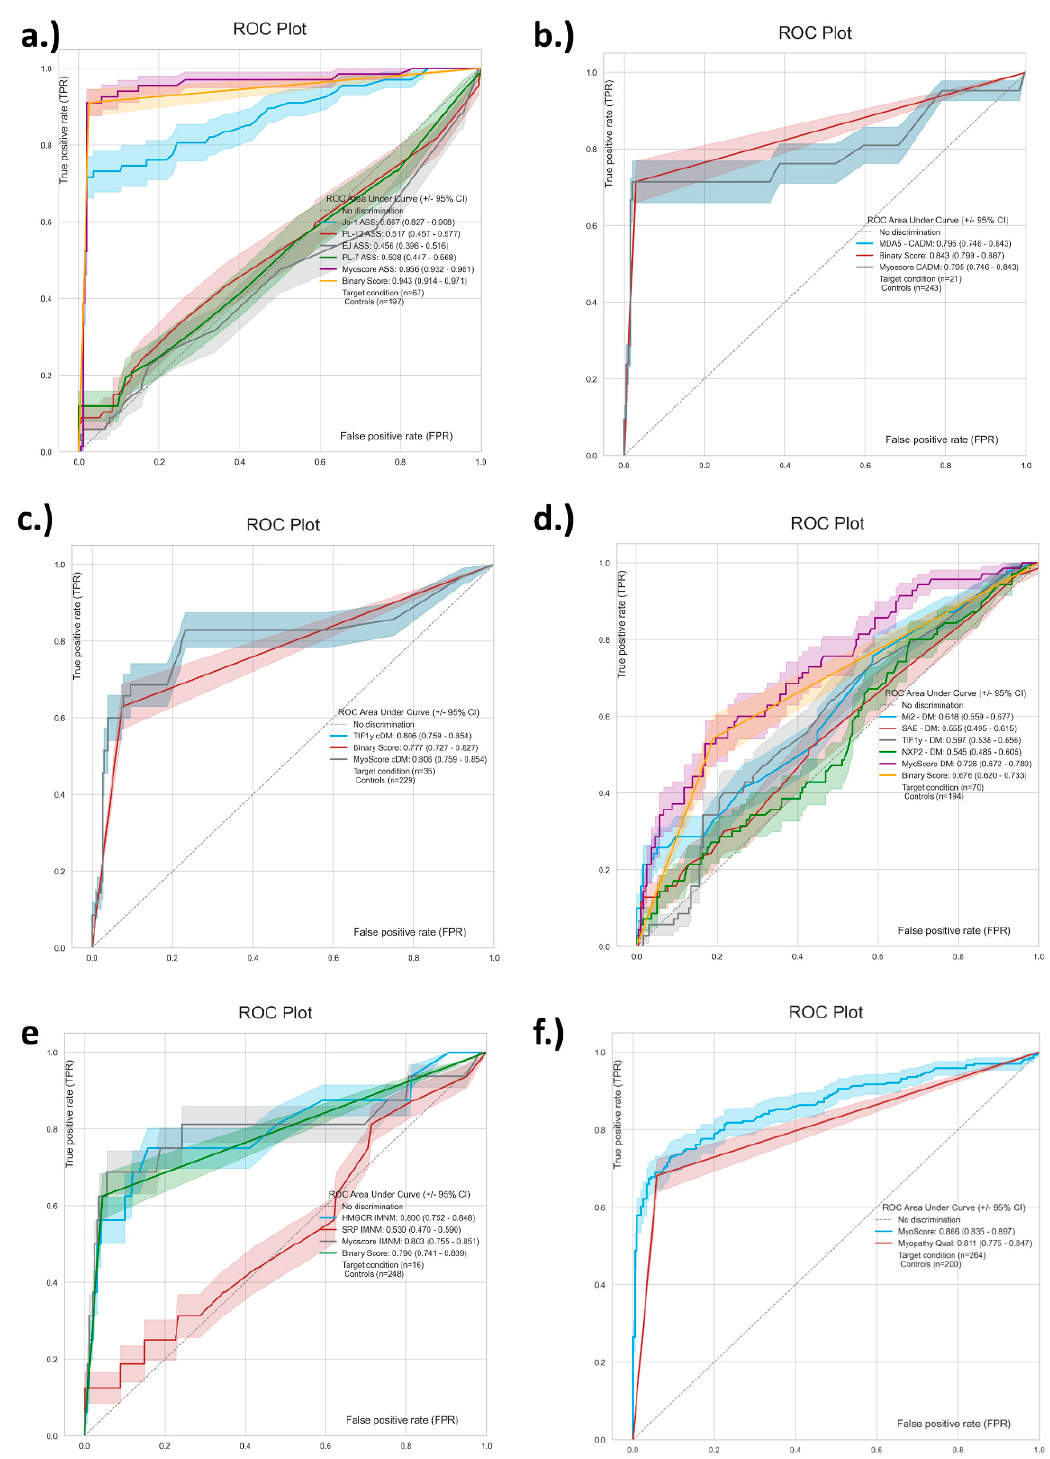
Figure 4. Receiver operating characteristic (ROC) analyses of scores to differentiate myositis phenotypes. The ROC curves showed variable discrimination between the different idiopathic inflammatory myopathy (IIM) subtypes. ( a ) shows the discrimination of antibodies to Jo-1, PL-7, PL-12 and EJ combined in a score to identify anti-synthetase syndrome (ASS) patients. Panel ( b , c ) display the curve for MDA5 and clinically amyopathic dermatomyositis and for TIF1 γ for cancer associated dermatomyositis. Panel ( d ) visualizes the combination of Mi-2, SAE, TIF1 γ , NXP2 in a score for dermatomyositis. In ( e ) the combination of SRP and HMGCR for immune-mediated necrotizing myopathy (IMNM) is displayed. Panel ( f ) shows the total score for IIM. The area under the curve (AUC) values are shown in the individual panels.